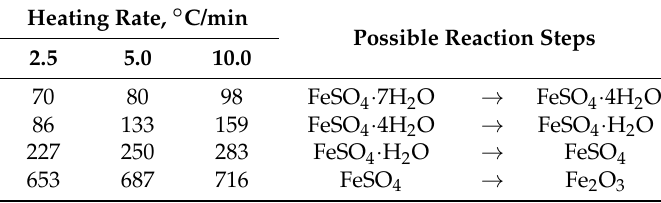
Table 2. Endothermic peaks (°C) revealed by differential thermal (DT) analysis for the treatment of FeSO 4 ∙ 7H 2 O under nitrogen at various heating rates. Heating Rate, °C/min 2.5